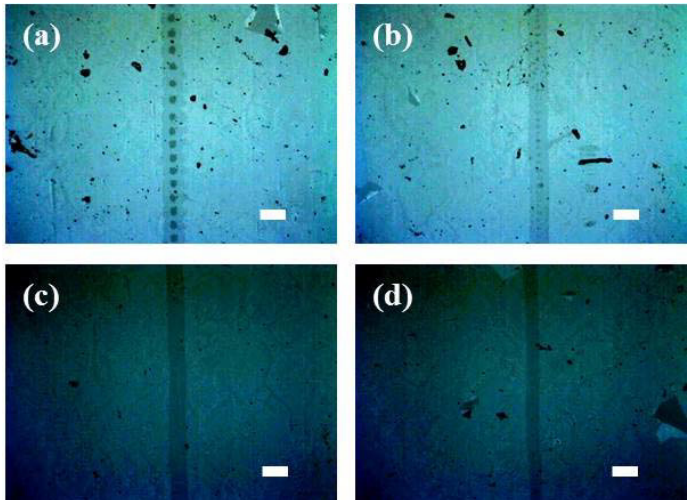
4b could be due to the overlapping of the laser beam.